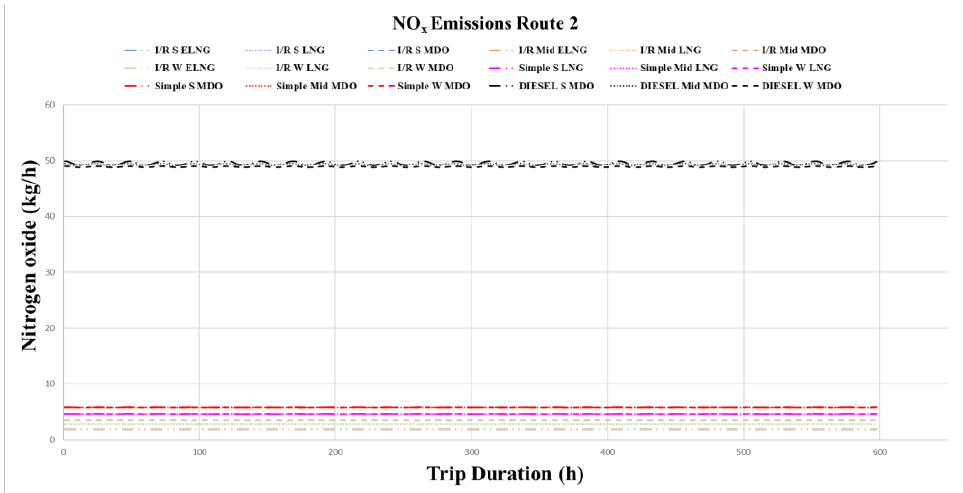
Figure 9. NO x emissions of various propulsion systems of the large container ship travelling between Shanghai and Hamburg. I/R: intercooler/reheater CCGT; R: reheater CCGT; S simple CCGT; Diesel: two-stroke diesel engine; W: winter; Mid: midseason; S: summer.